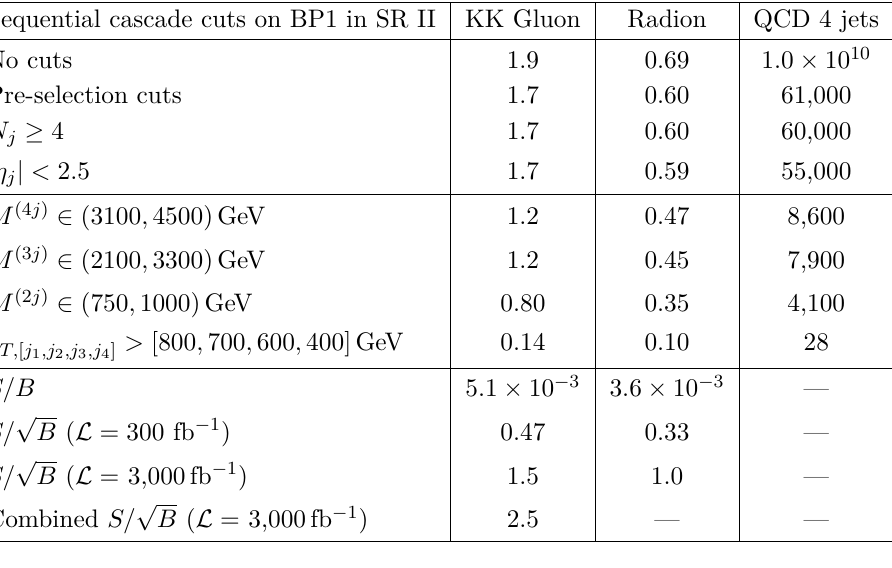
Table 4 . Cut flows of BP1 in SR II ( g grav = 6 , g g 3 TeV , and m ϕ = 1 TeV , see also table 1) and QCD 4-jet backgrounds at the 14 TeV LHC with cuts designed for the sequential cascade topology. The values of cross-sections are in fb. The reported no-cut cross-sections in the second and the third columns are the production cross-section of KK graviton multiplied by the associated branching fractions. The pre-selection cuts are p [600 , 400 , 200 , 100] GeV, ∆ R jj > 0 . 4 , and | η j | < 4 . For the trijet invariant mass window cut, we test whether (at least) one trijet invariant mass value out of four possible combinations satisfy the condition.